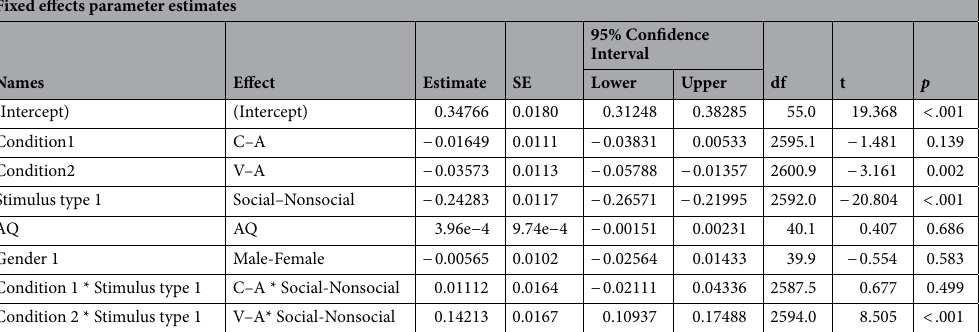
Table 2. Parameter estimates for the fixed effects of the model. Conditions are denoted as follows (A: Auditory, C: Combined, V: Visual). Stimulus Types are denoted as Social or Nonsocial.